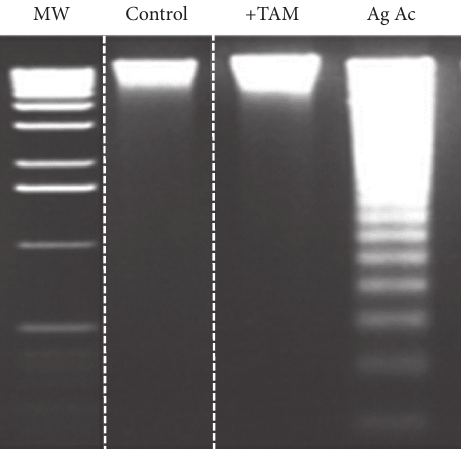
Figure 3: Effect of agaric acid on mitochondrial DNA disruption and its protection by the antioxidant tamoxifen. Experimental conditions were as described under Materials and Methods. Where indicated, 3 µ M agaric acid and 20 µ M tamoxifen (+Tam) were added. The image is representative of 3 different experiments.